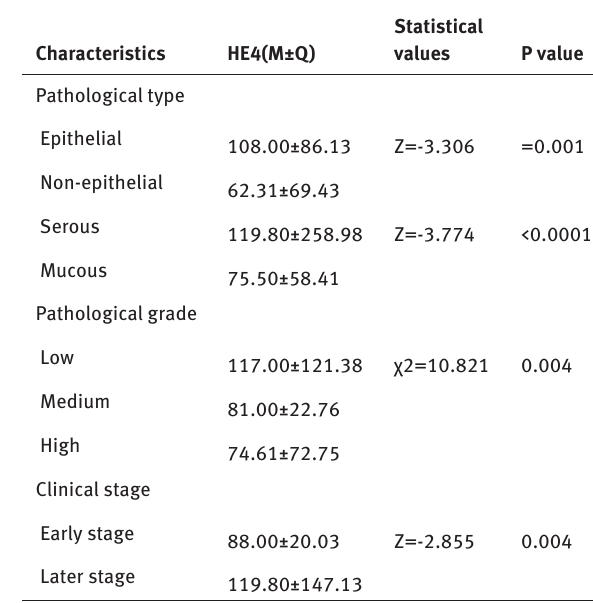
Table 2: Relationship between serum HE4 and pathological type, grading and clinical staging in group of malignant ovarian